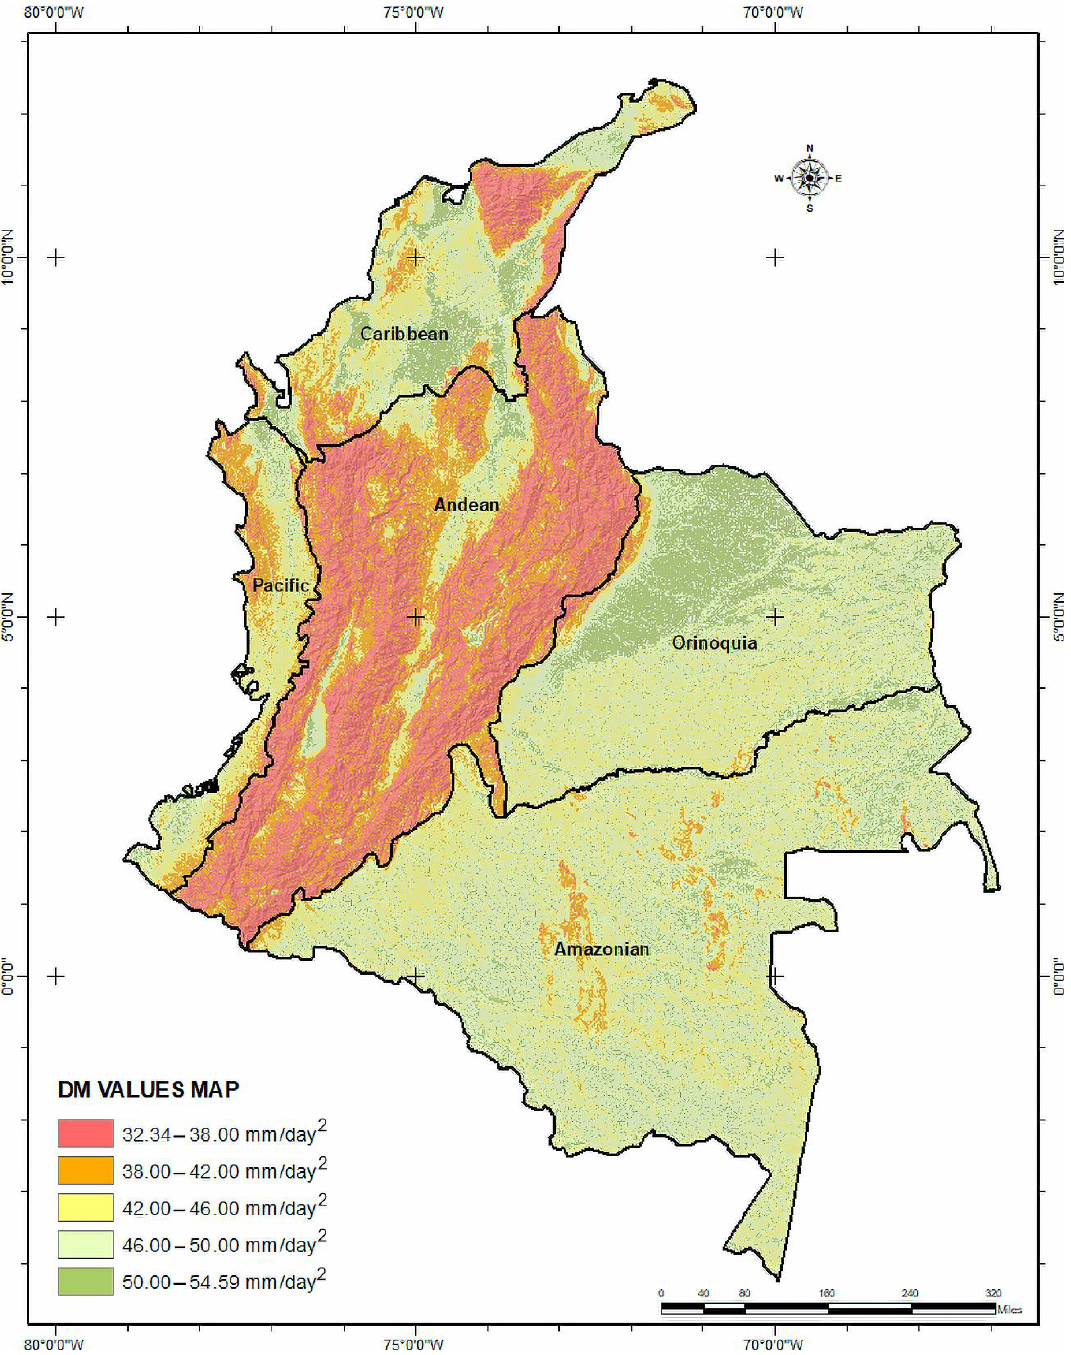
Figure 9. DynamicMap quantities between two rainfall episodes that will trigger a landslide once exceeded at that specific slope angle. Days are expressed as (day 2 ) as per Equation (12) where the two rainfalls average is measured in mm/day and then are divided by the dry period between the two rainfalls, also measured in days.